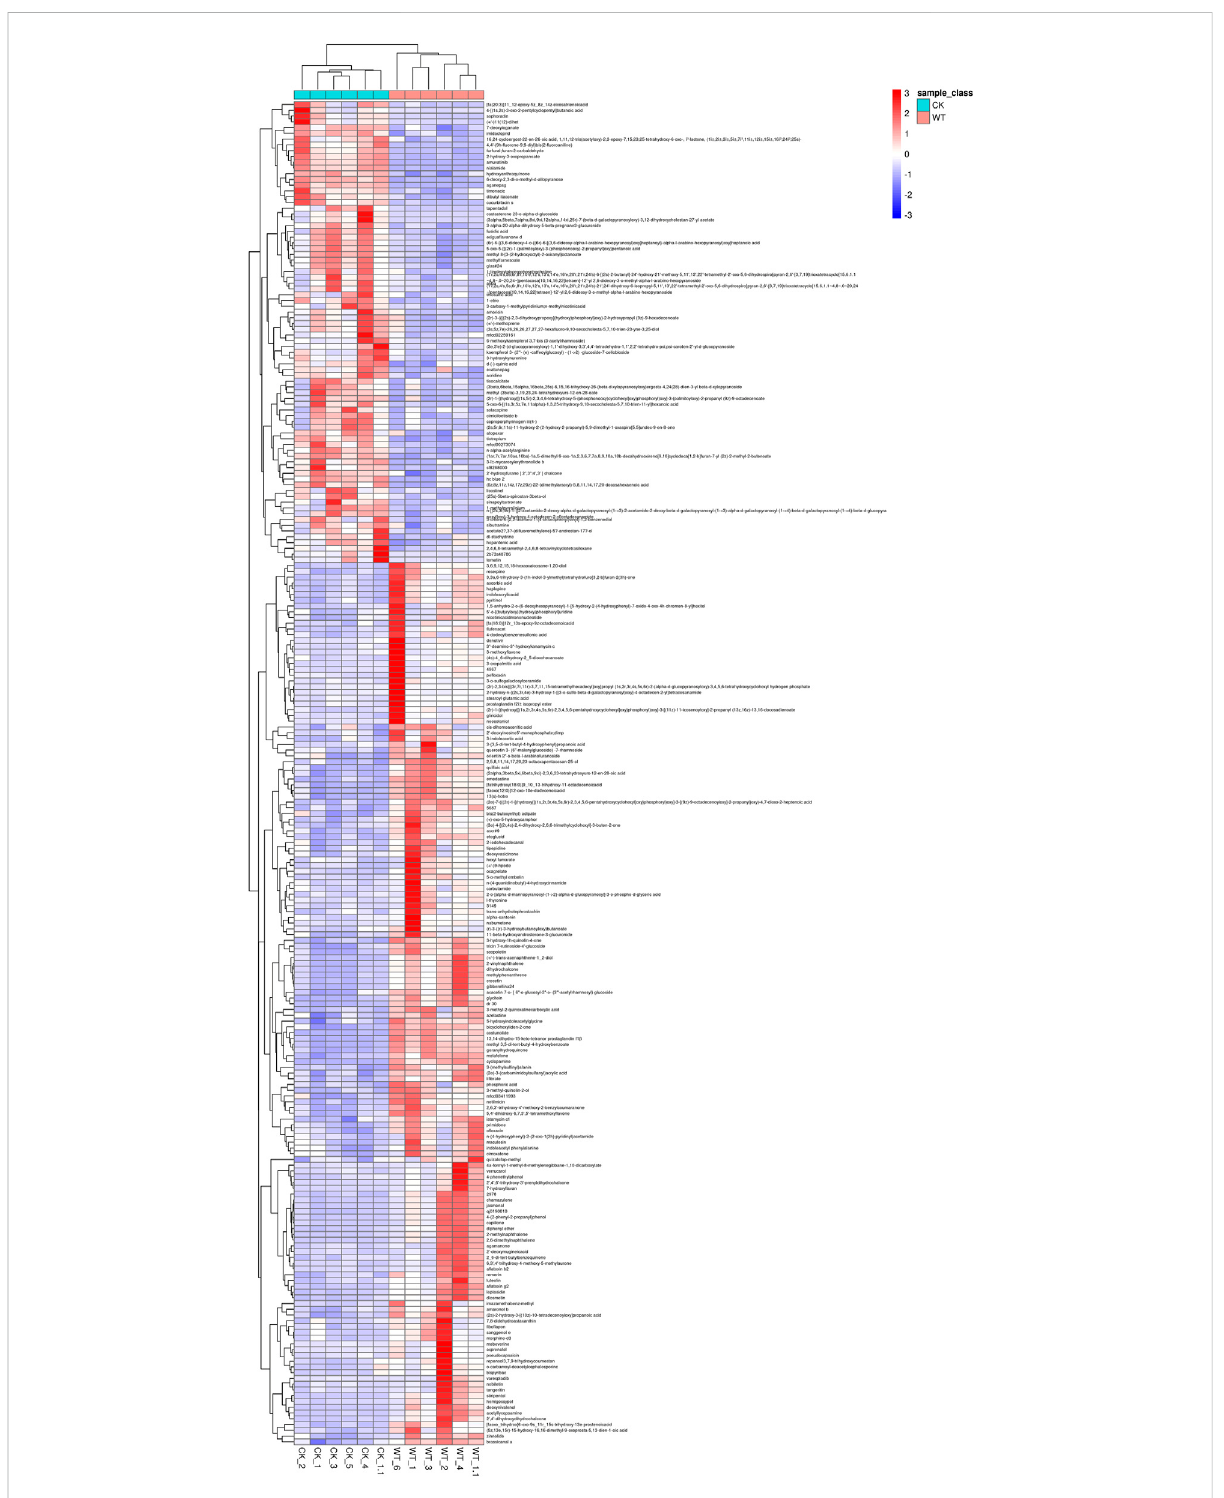
FIGURE 2 Hierarchical clustering analysis of differentially expressed metabolites between the control and AR-Cd treatment. (CK-WT heatmap-